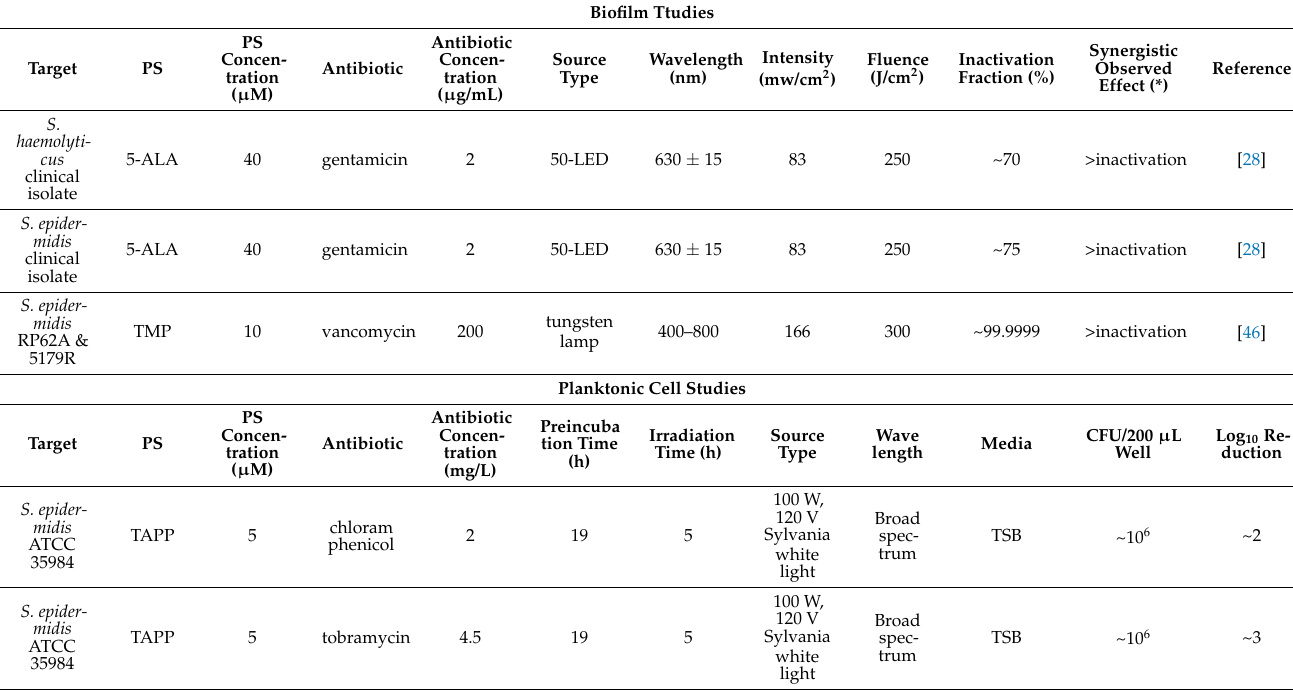
(Table 2: Biofilm Studies and biofilm state, planktonic—Table 2: Planktonic Cell Studies). Table 2. Studies combining in vitro aPDT plus other treatment against S. haemolyticus and S. epidermidis comparing the methodology and the results biofilm studies, planktonic cell